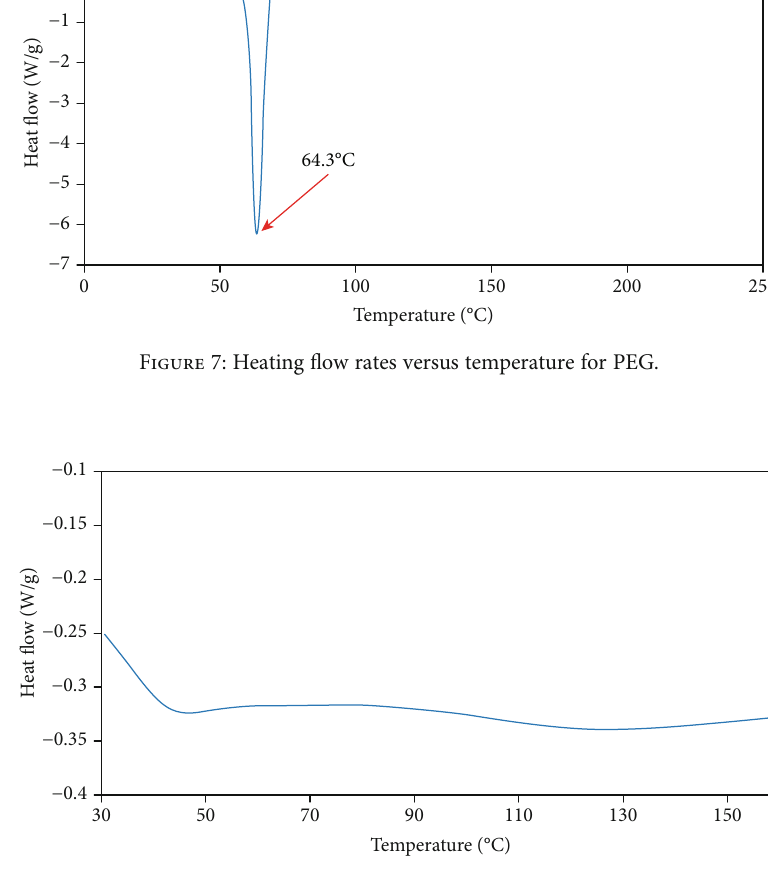
Figure 8: Heating fl ow rates versus temperature for cured